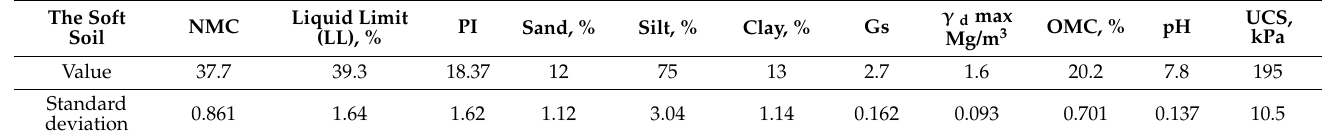
Table 1. Soil properties and classification.